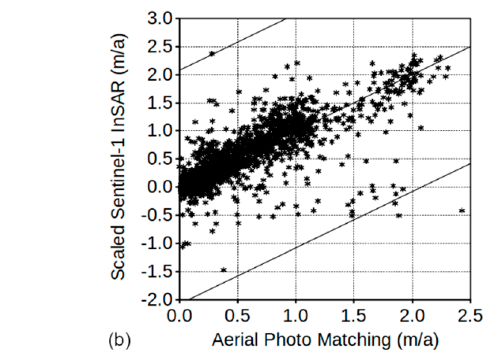
Figure 14. Distelhorn rock glacier (Mattertal, Switzerland). ( a ) Sentinel-1 InSAR line-of-sight velocity map from 02.08.2018 to 08.08.2018; ( b ) Horizontal velocity map from matching of aerial optical images with a spatial resolution of 0.15 m acquired on 03.09.2014 and 21.09.2017; ( c ) Difference map between aerial photo matching and Sentinel-1 InSAR LOS velocities.